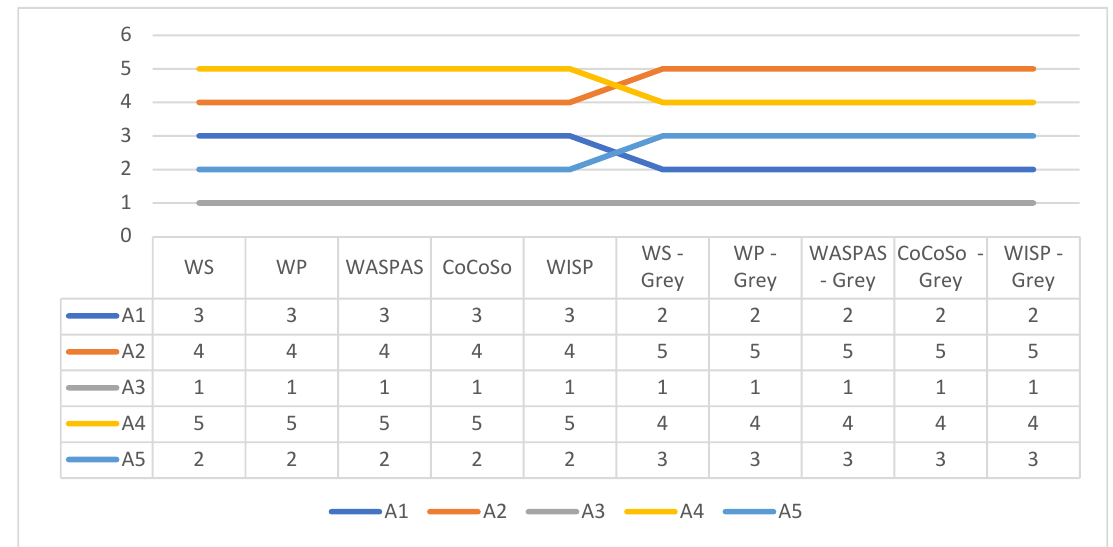
Table 17. Ranking orders of alternatives obtained on the basis of 100 virtual respondents. Crisp